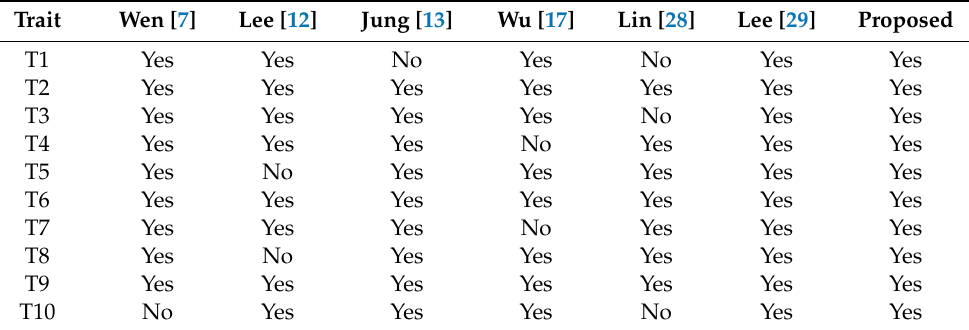
Table 3. Security comparison table.